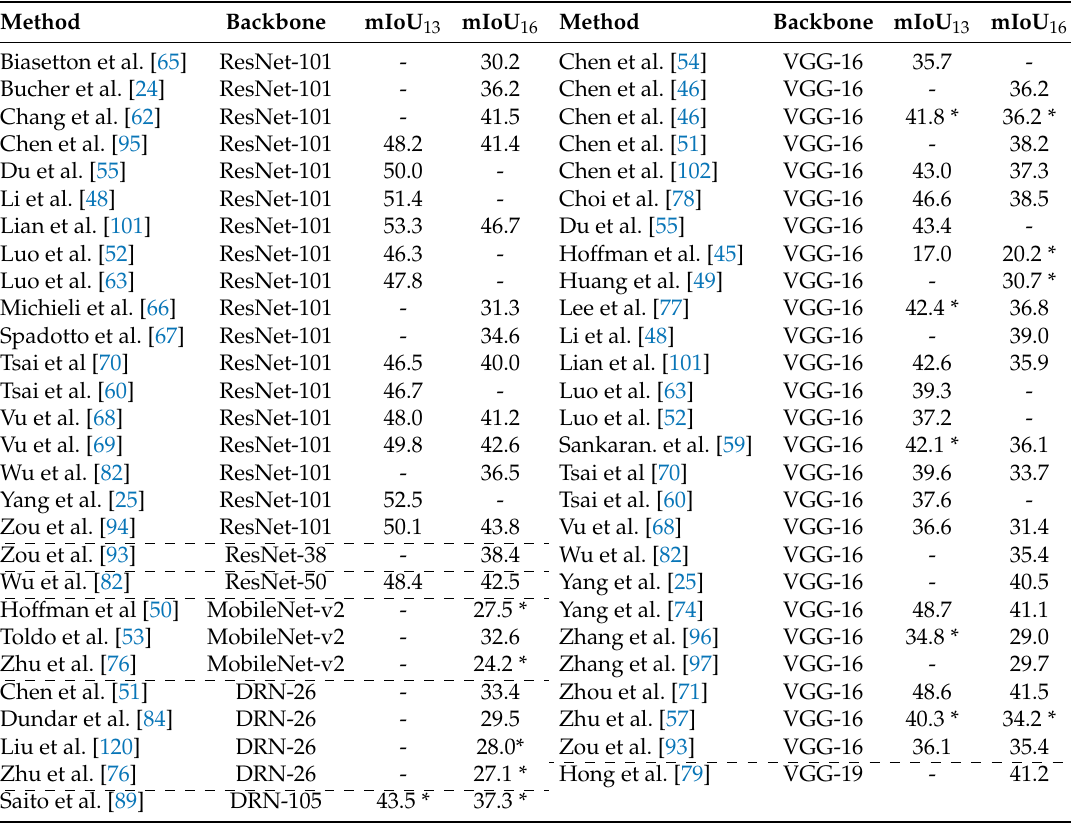
Figure 8. Mean IoU on 16 classes (mIoU 16 ) of different methods grouped by backbone in the scenario adapting source knowledge from SYNTHIA to Cityscapes (see Table 2). Backbones are sorted by decreasing number of entries. Orange crosses represent the per-backbone mean mIoU. Only the backbones with 3 or more entries are displayed. Table 2. Mean IoU (mIoU) for different methods grouped by backbone in the scenario adapting source knowledge from SYNTHIA to Cityscapes. The table reports the mIoU computed over 13 or 16 semantic classes depending on the label set used in the corresponding